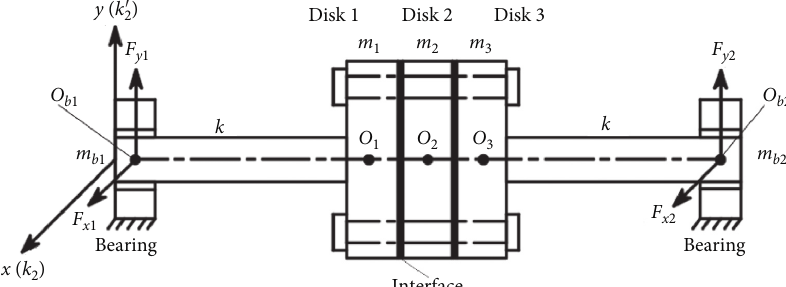
Figure 2: Dynamic model of a rod fastening